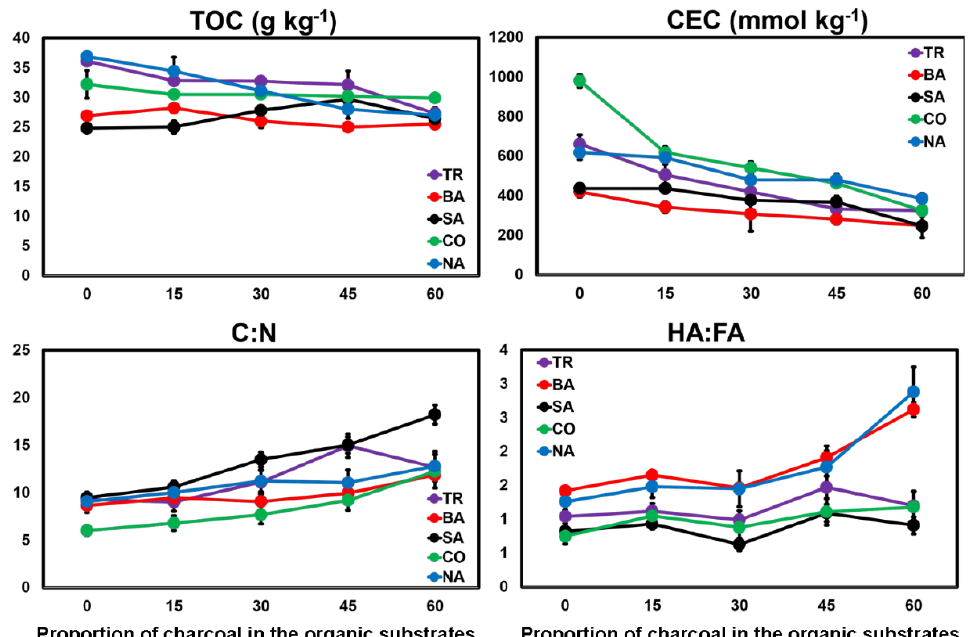
Figure 4. Total organic carbon content (TOC), cation exchange capacity (CEC), C:N and humic acid/fulvic acid (HA/FA) ratios of organic amendments made from mixtures of composts and char- coal. Composts were made from poultry industry wastes and tree trimmings (TR), sugarcane ba- gasse (BA), sawdust (SA), cotton residues (CO), and Napier grass (NA). The numbers 0, 15, 30, 45, and 60 correspond to the proportion of charcoal in the organic amendment (%, weight basis). Error bars represent standard deviations.